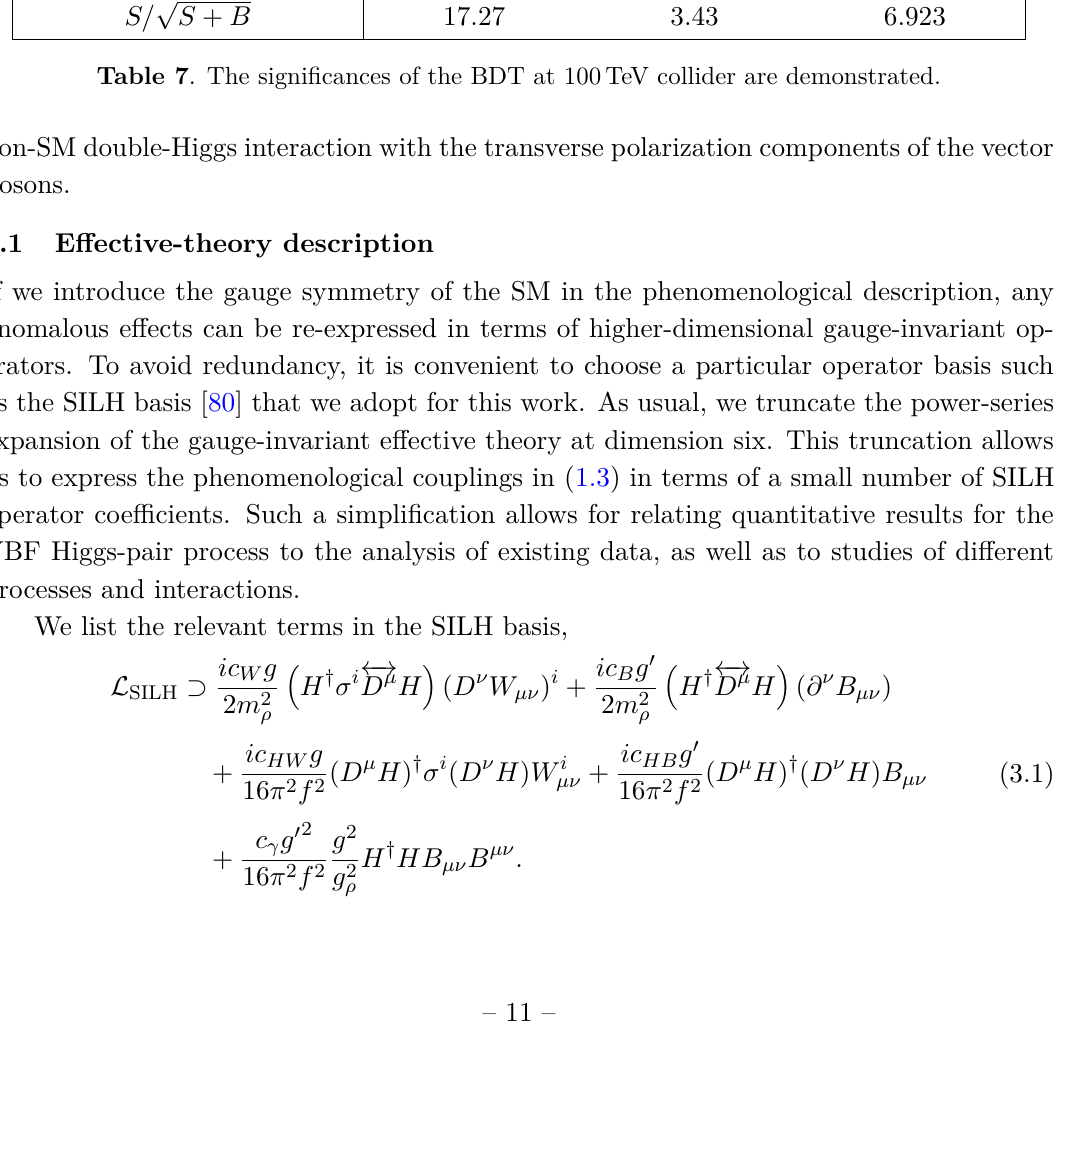
Table 7 . The significances of the BDT at 100 TeV collider are